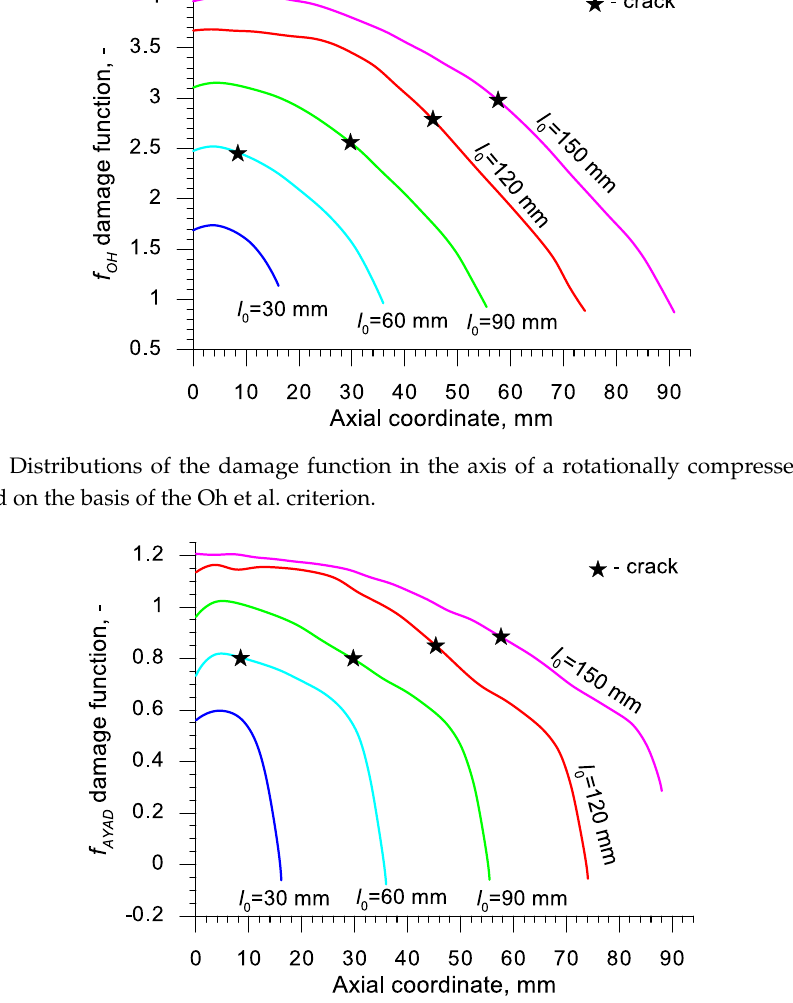
Figure 25. Distributions of the damage function in the axis of a rotationally compressed sample, determined on the basis of the Ayada criterion.